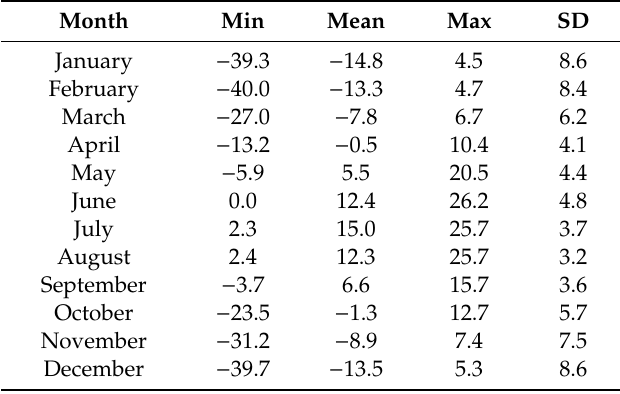
Table 1. Descriptive statistics of temperature in ◦ C, 1860–1899.